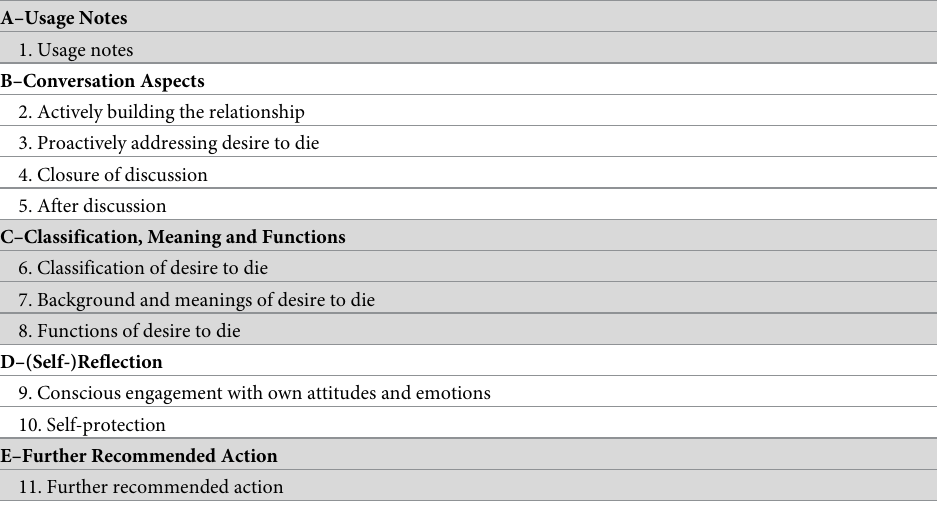
Table 1. Eleven domains of the semi-structured clinical approach as originally presented in Kremeike, 2020